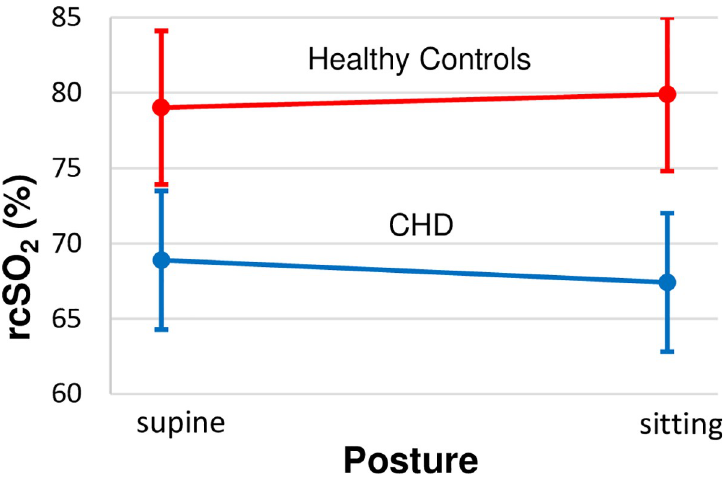
Fig 4. Marginal means for postural effects on cerebral oxygenation. This figure demonstrates the direction of effects for cerebrovascular stability in each group. rcSO 2 values are least square means estimated from the generalized estimating equation that tested our a priori hypotheses and are adjusted for postconceptional age, sex, ethnicity, and SpO 2 . Brain oxygen saturation decreased from the supine to sitting posture in CHD infants, but it increased slightly in healthy controls. Error bars represent standard error. CHD = congenital heart disease; rcSO 2 = regional cerebral oxygen